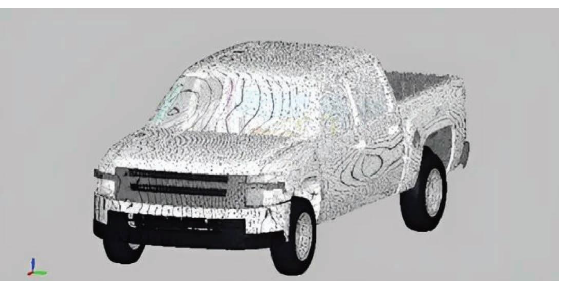
Figure 6: Meshed